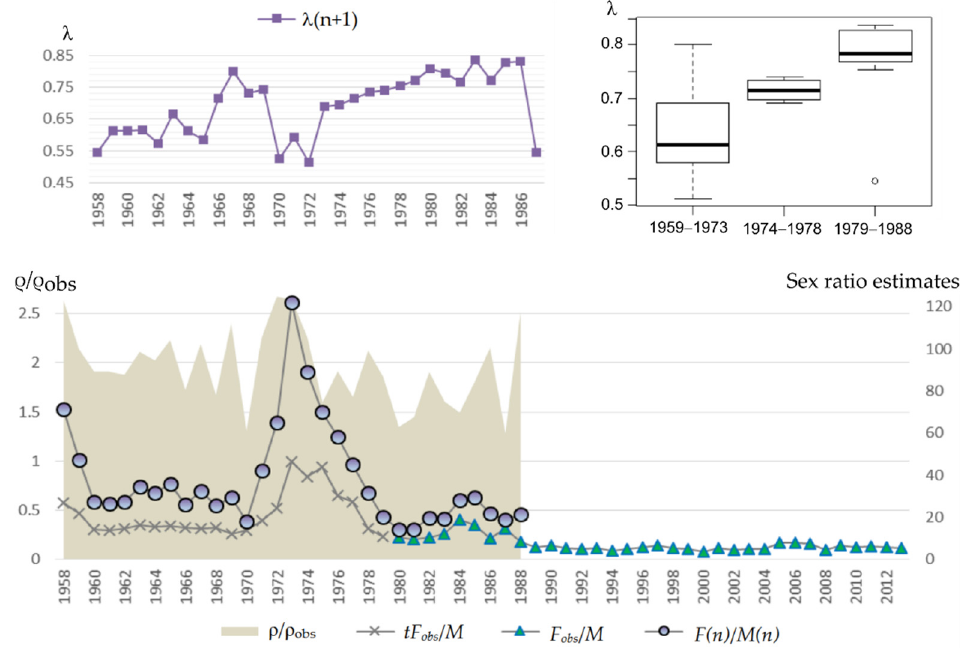
Figure 9. ( bottom ) Dynamics of actual sex ratio ρ = F ( n )/ M ( n ) for the period 1958–1988, visual sex ratio ρ obs = F obs ( n )/ M ( n ) for 1980–2013, supplemented by calculated ones tF obs ( n )/ M ( n ) for 1958–1979 based on Equation (5) ( on the right axis ); and ρ / ρ obs ( on the left axis ). ( top ) Dynamics of pregnant females’ proportion in the next year λ ( n + 1 ) ( on the left ), and a box plot of λ ( n + 1 ) for the periods corresponding to different reproductive efficiency of bulls ( on the right ).